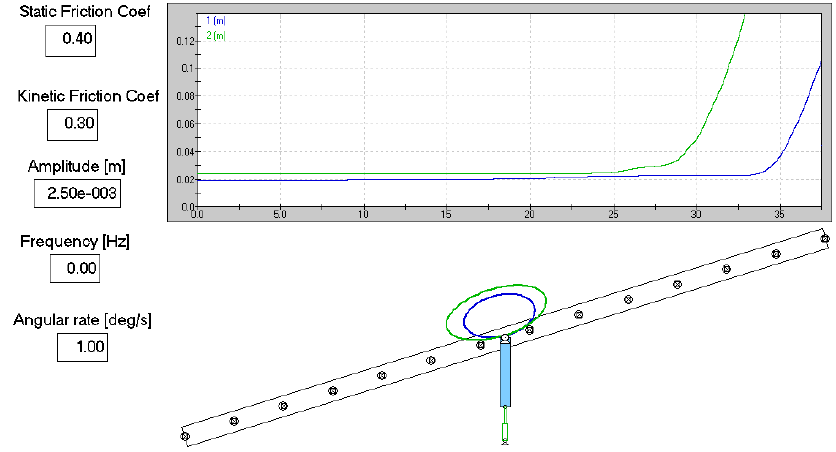
Figure 4. Working Model 2D simulation of the chain bar of the digging and lifting device with a slowly increasing angle, showing the difference in backsliding between large and average-size potatoes.